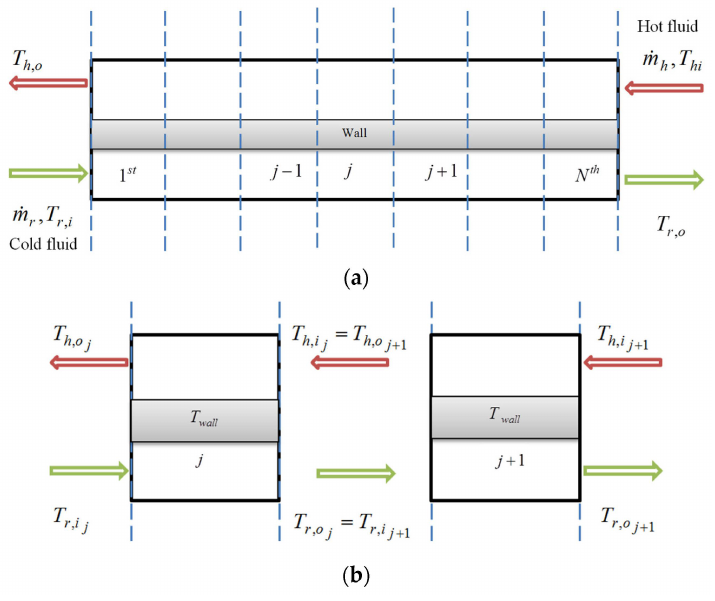
Figure 4. ( a ) Finite volume evaporator model; ( b ) Relationship between input and output variables.